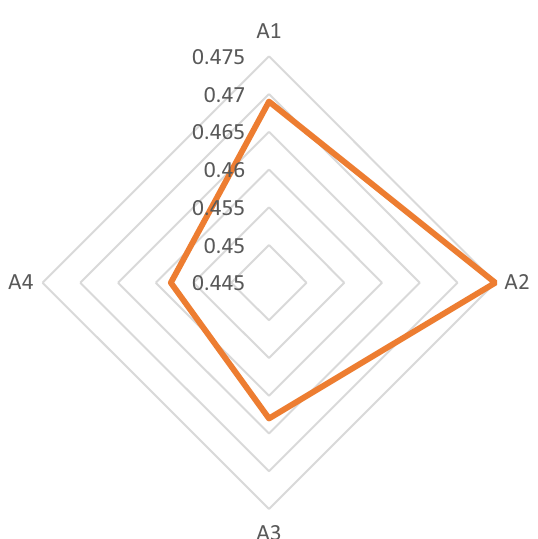
Fig. 5 Closeness coefficient ( CC i ) values